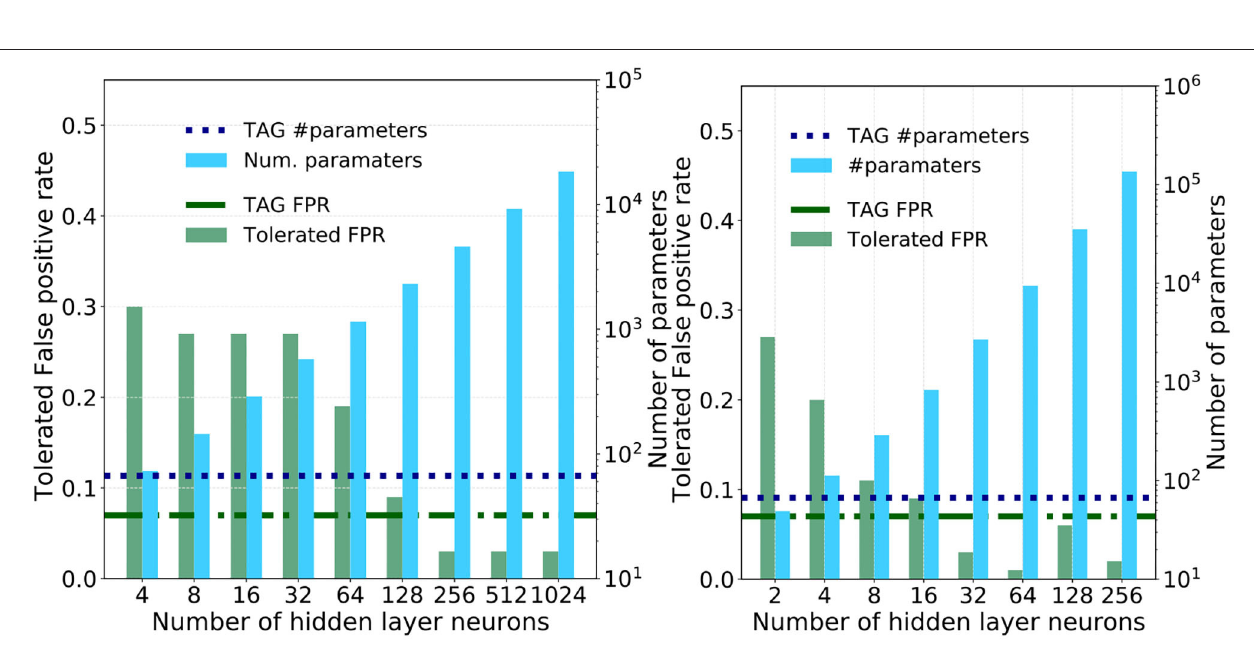
Frontiers in Neuroscience |